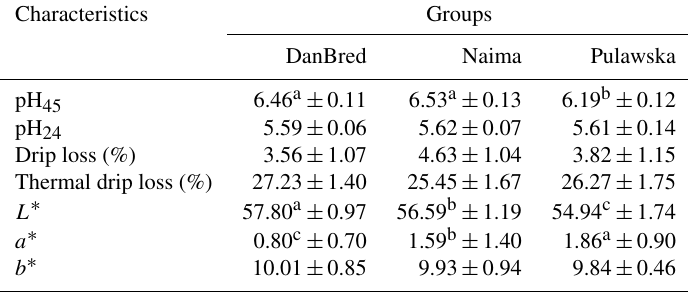
Table 1. Physical properties of the longissimus lumborum muscle in pigs.